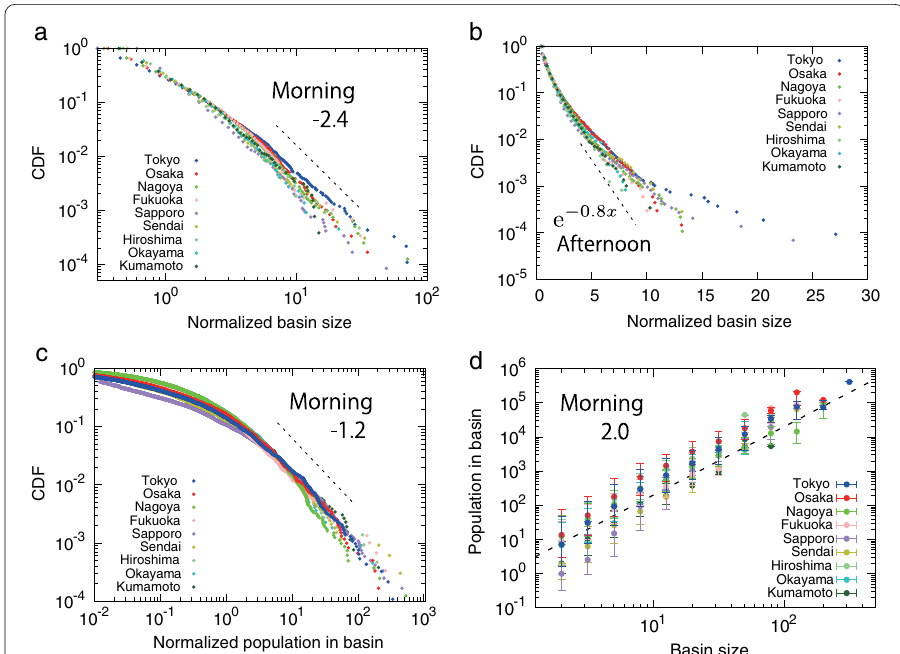
Fig. 4 Cumulative distribution function (CDF) of basin size and population distributions for 9 cities during COVID-19 pandemic. a , CDFs of basin sizes in the morning rush hour for the 9 analyzed cities (Tokyo, Osaka, Nagoya, Fukuoka, Sapporo, Sendai, Hiroshima, Okayama and Kumamoto) during COVID-19 (from April 7 to June 30, 2020), where basin sizes are normalized by the mean basin size. We prepare human flow that accumulates weekday data from April 7th to June 30th, 2020, and calculate drainage basins. CDFs of the morning commuter rush hour are approximated by a power distribution of the same exponent − 2.4 as before the spreading of COVID-19 pandemic (Shida et al. 2020). b , The afternoon size distribution during COVID-19 pandemic. Comparing with the same plots for the year of 2016 before the pandemic shown in Fig. 8b, the distributions have longer tails deviating clearly for Tokyo and Sapporo. c , In the morning rush hours, CDFs of population of moving people in the basin follow a power distribution of exponents − 1.2 , where the population in the basin is normalized by the average population in basins. This is again similar to that found in the non-pandemic times (Shida et al. 2020). d , The number of people moving in the basin during the morning rush hours is proportional to the square of the size of the